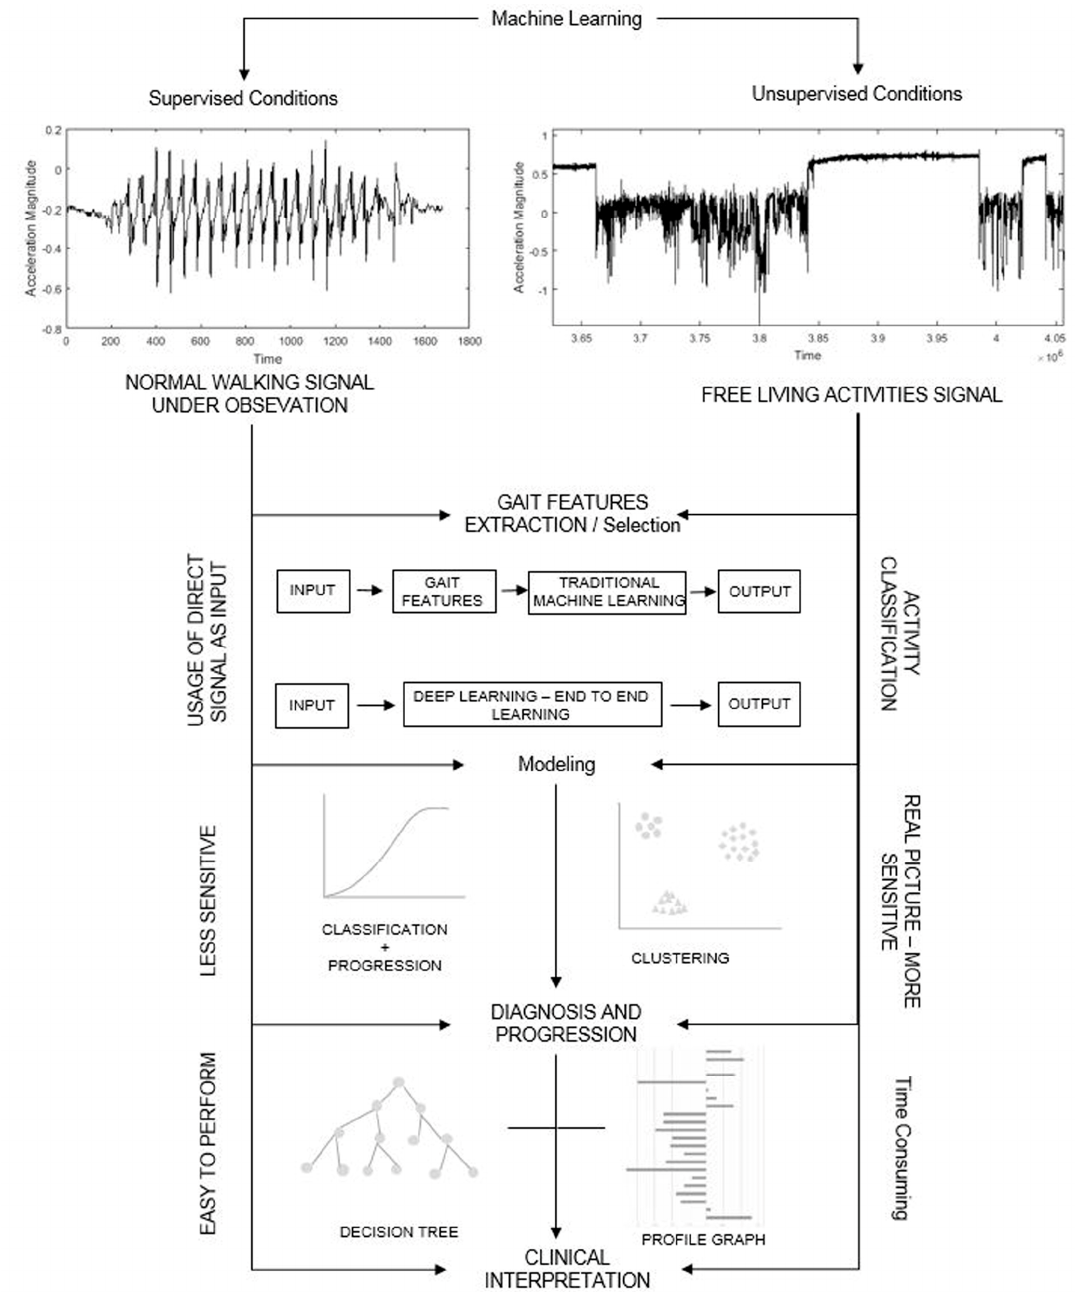
Figure 2. A machine learning end-to-end framework for the analysis of gait dynamics in the laboratory and community.